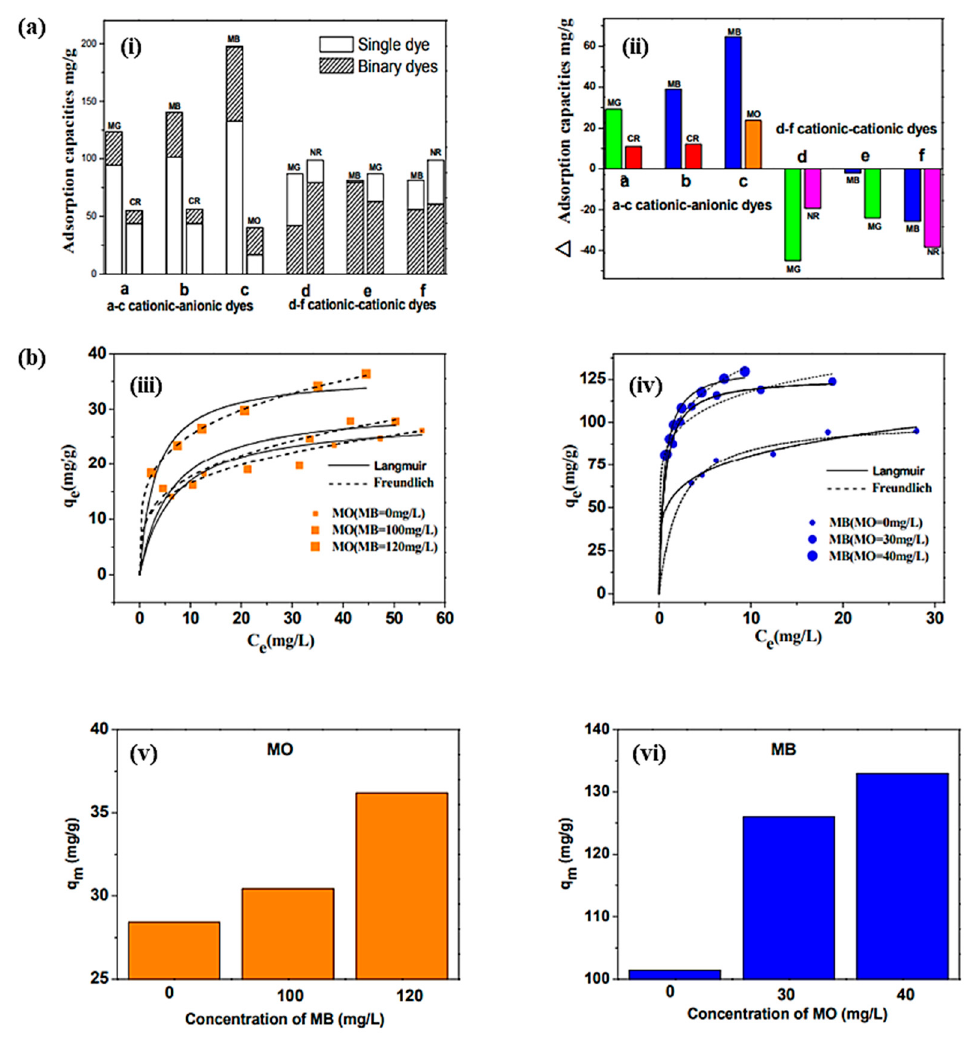
Figure 9. ( a ) ( i ) Adsorption capacities and ( ii ) their changes in single and binary dye systems. ( b ) Adsorption isotherms of methyl orange (MO) ( iii ) and methylene blue (MB) ( iv ) on CNTs/Fe@C fitted by the Langmuir and Freundlich models. The maximum adsorption capacity of MO ( v ) and MB ( vi ) increased with the concentration of the other dye [139]. Table 7. Applications of CNMs in wastewater treatment. COD, chemical oxygen demand.